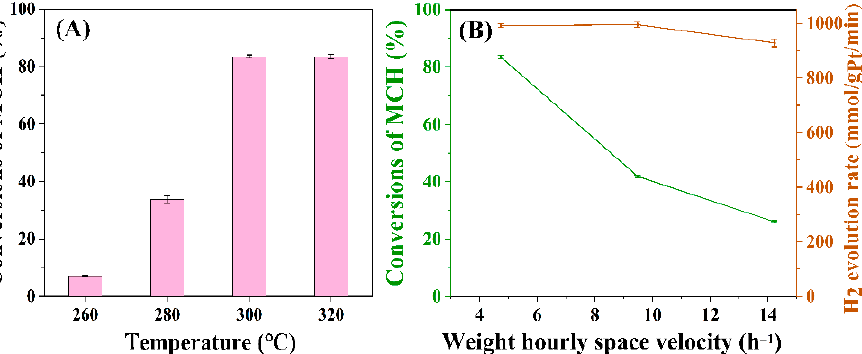
Figure 5. ( A ) The influence of reaction temperature on the conversion of MCH using Pt/PTC-S as the catalyst; ( B ) the effect of weight hourly space velocity (WHSV) on the conversion of MCH and the hydrogen evolution rate under the Pt/PTC-S catalyst.